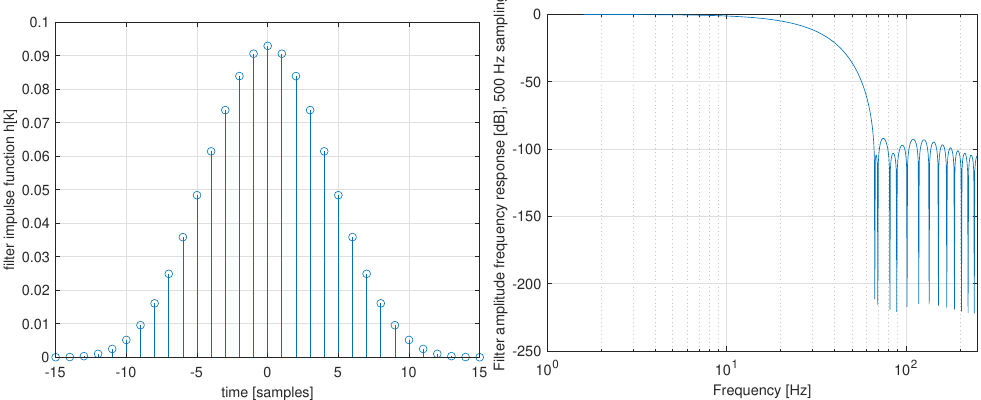
Figure 13. Example of Blackman-Harris zero-phase FIR filter design used motion smoothing— ( left ) filter impulse response, ( right ) amplitude frequency